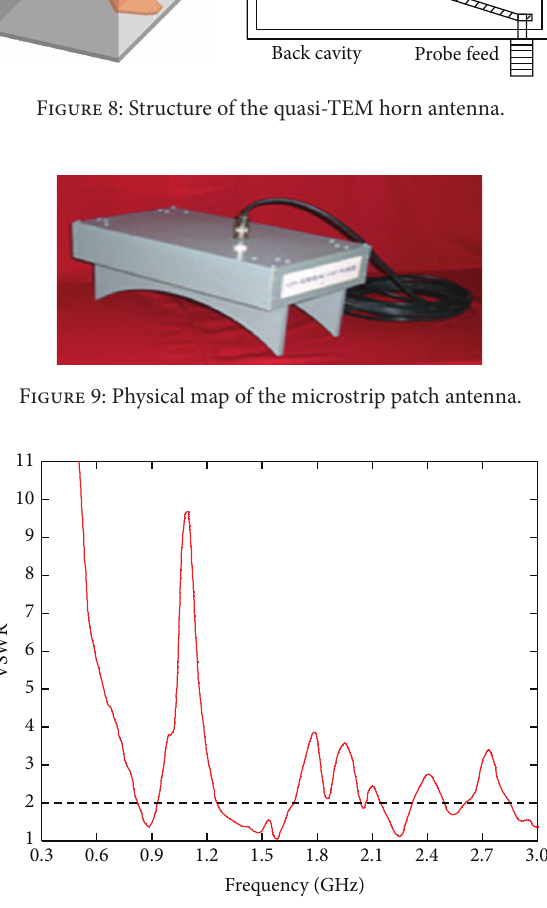
Figure 10: Measured VSWR of the quasi-TEM horn antenna.